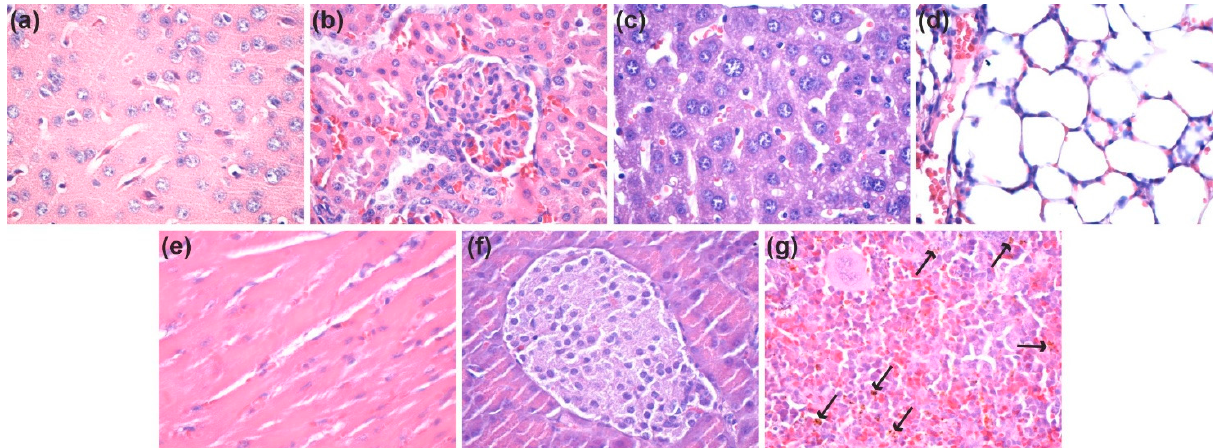
Figure 15. Micrographs of cross-sections through the mice internal organs treated with ZnO NPs after seven days (HE staining, ×400): ( a ) Brain; ( b ) Kidney; ( c ) Liver; ( d ) Lung; ( e ) Myocardium; ( f ) Pancreas; ( g ) Spleen (see arrows for ZnO@LiN NPs). HE: Hematoxylin–Eosin; NPs: Nanoparticles. (×100).